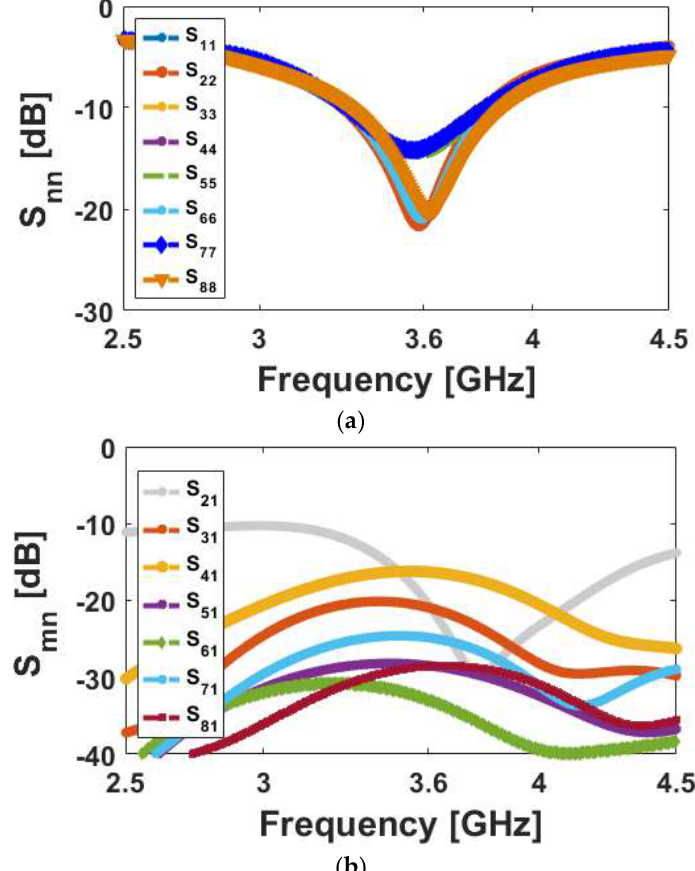
Figure 10. ( a ) S nn and ( b ) S mn results of the mobile-phone antenna.